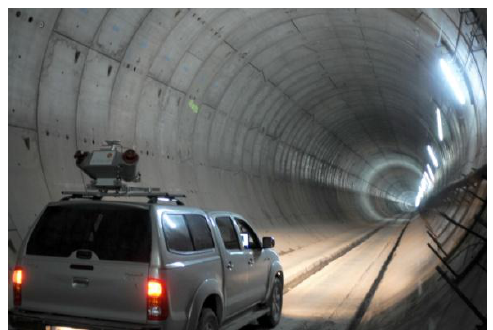
Figure 2. Riegl VMX-250-CS6 mobile laser scanning system in operation in a tunnel survey.